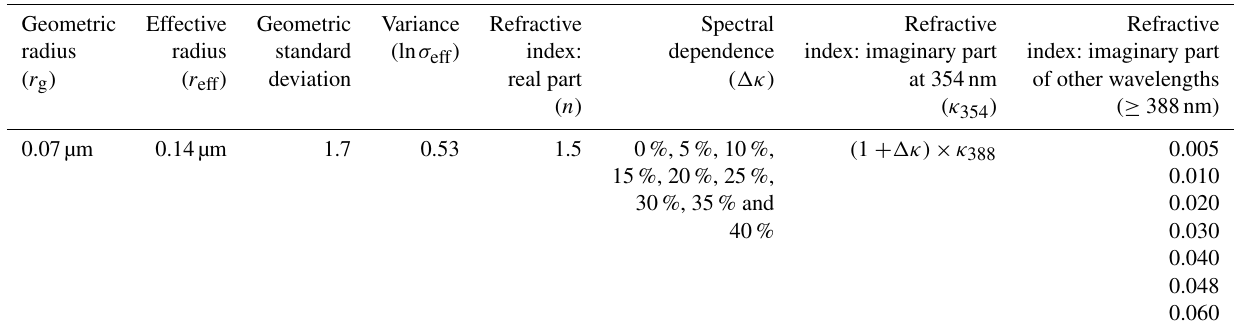
Table 1. Aerosol models used in the forward radiative transfer calculations. (cid:49)κ is the relative difference between κ 354 and κ 388 , defined as (cid:49)κ = (κ 354 − κ 388 )/κ 388 . Geometric Effective Geometric Variance Refractive Spectral Refractive Refractive radius radius standard (ln σ eff ) index: dependence index: imaginary part index: imaginary part deviation real part